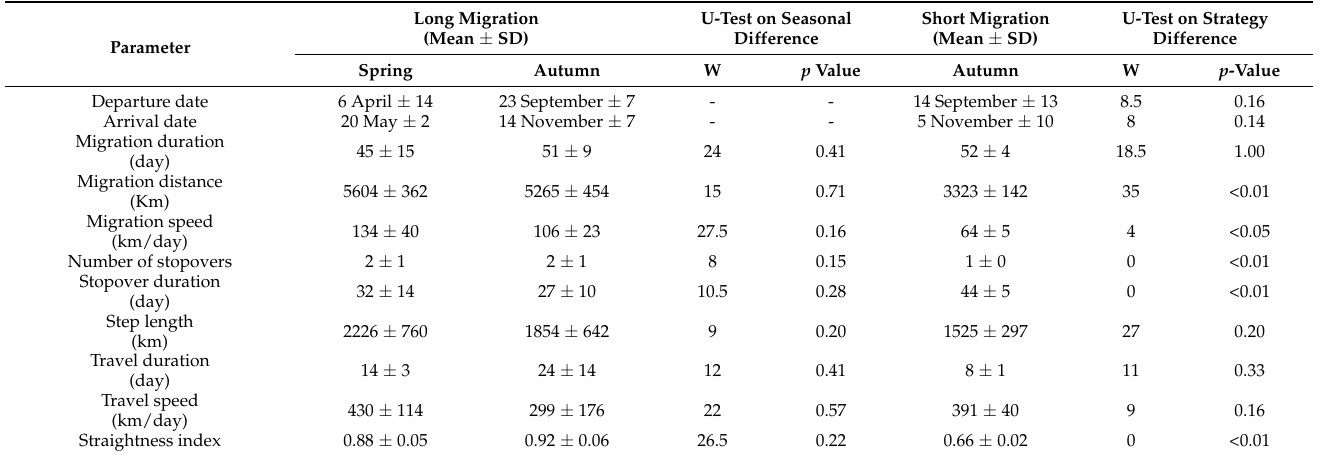
Table 1. Statistical comparison of the key spring and autumn migration parameters of nine Siberian cranes ( Leucogeranus leucogeranus ) based on the Mann–Whitney U